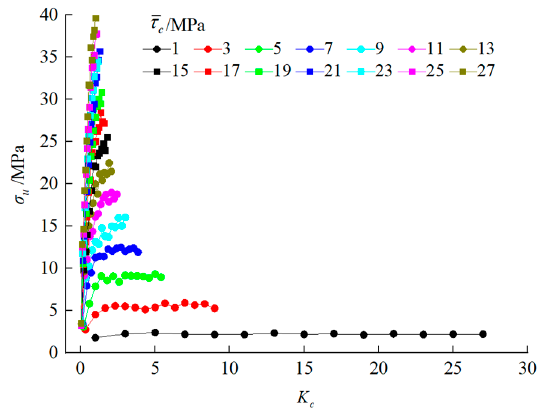
Figure 4. Effects of tensile-hear bond strength ratio on peak strength.